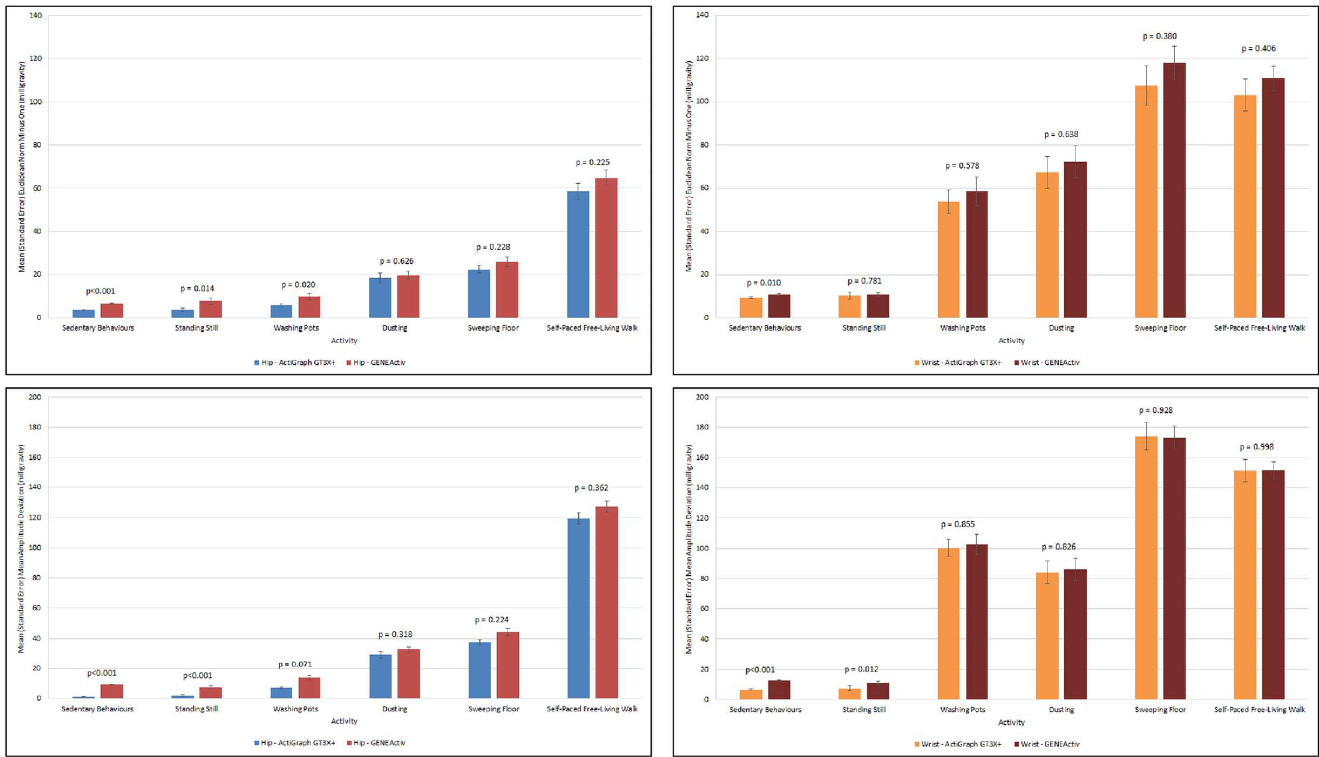
Fig 1. Euclidean Norm Minus One (ENMO) and Mean Amplitude Deviation (MAD) calculated from the ActiGraph GT3X+ and GENEActiv raw acceleration data (MAD) (Top Left: ENMO—Hip, Top Right: ENMO—Wrist, Bottom Left: MAD—Hip, Bottom Right: